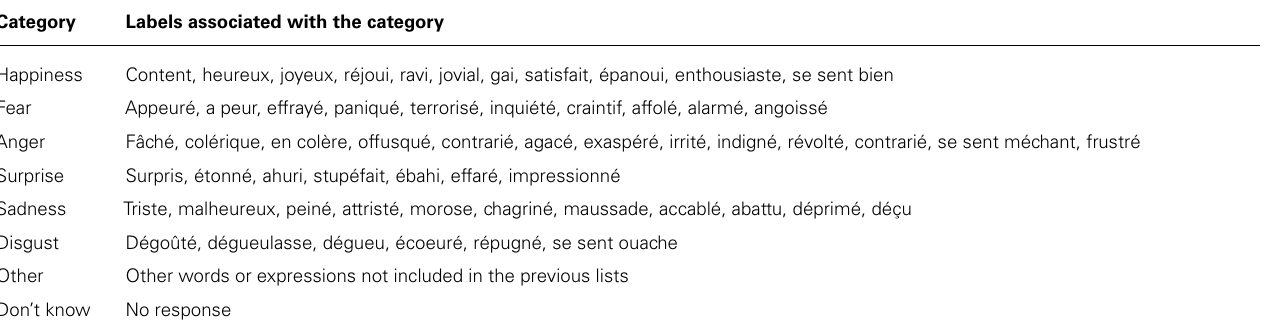
Table 1 | Scoring scheme used to classify children’s labels into emotion categories. Category